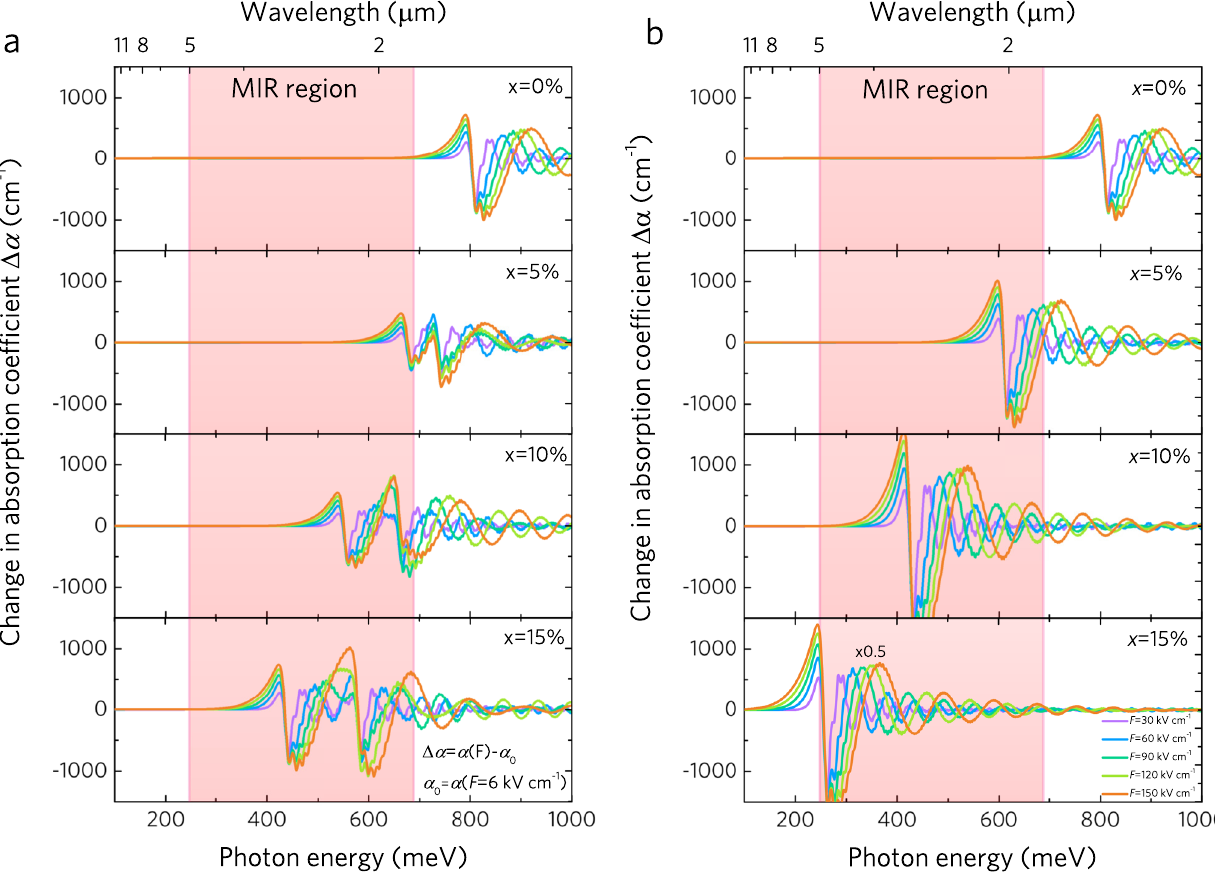
Fig. 5 Theoretical modeling for Franz – Keldysh effect in GeSn. Calculated change-in-absorption coef fi cient Δ α at T = 300 K for a pseudomorphic Ge 1 − x Sn x on Ge and b unstrained Ge 1 − x Sn x with different Sn contents and electric fi